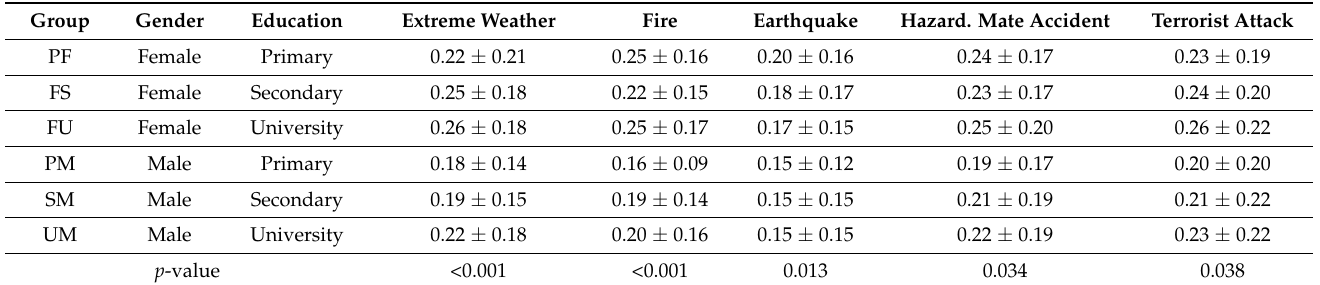
Table 12. Mean and standard deviation of risk scores [0, 1] by gender and education and p -values from the Kruskal-Wallis test ( α = 0.05).